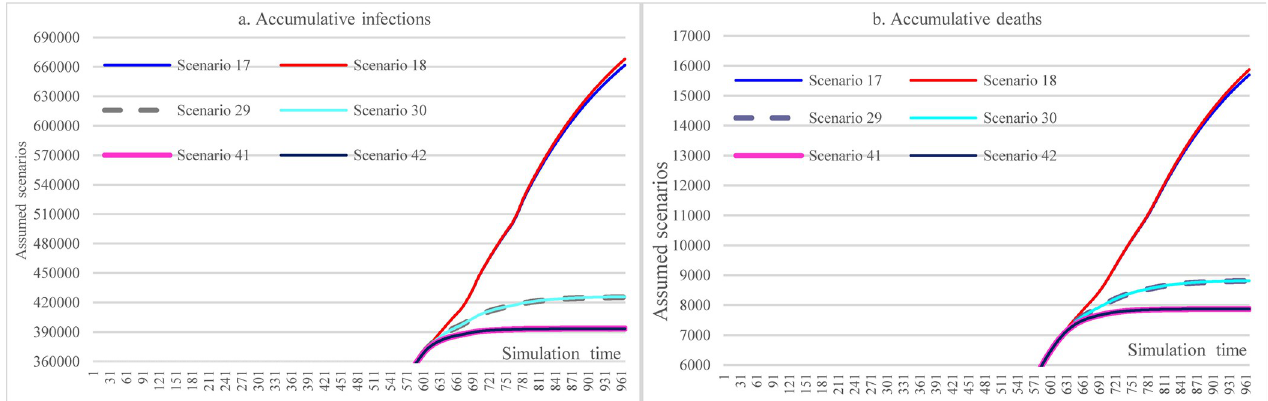
Fig 9. Impacts of increasing adherence level of mask-wearing in scenario analysis.